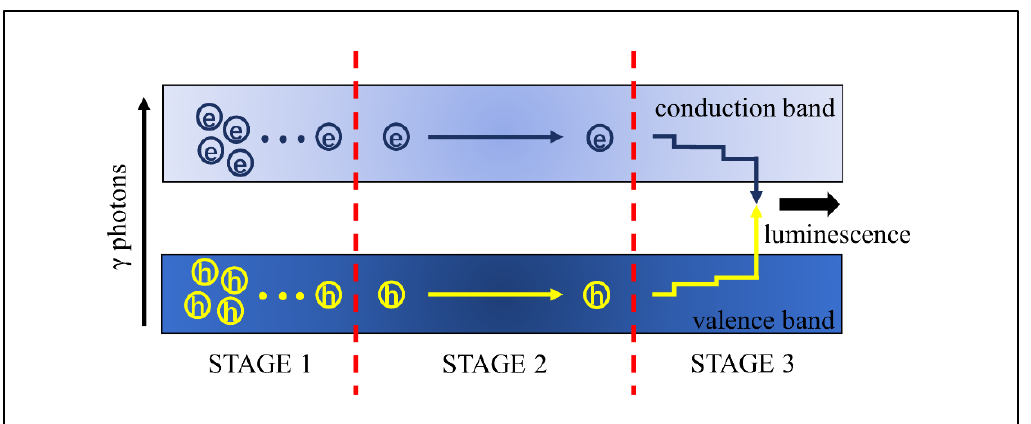
Figure 1. Luminescence process of scintillation crystals in PET.